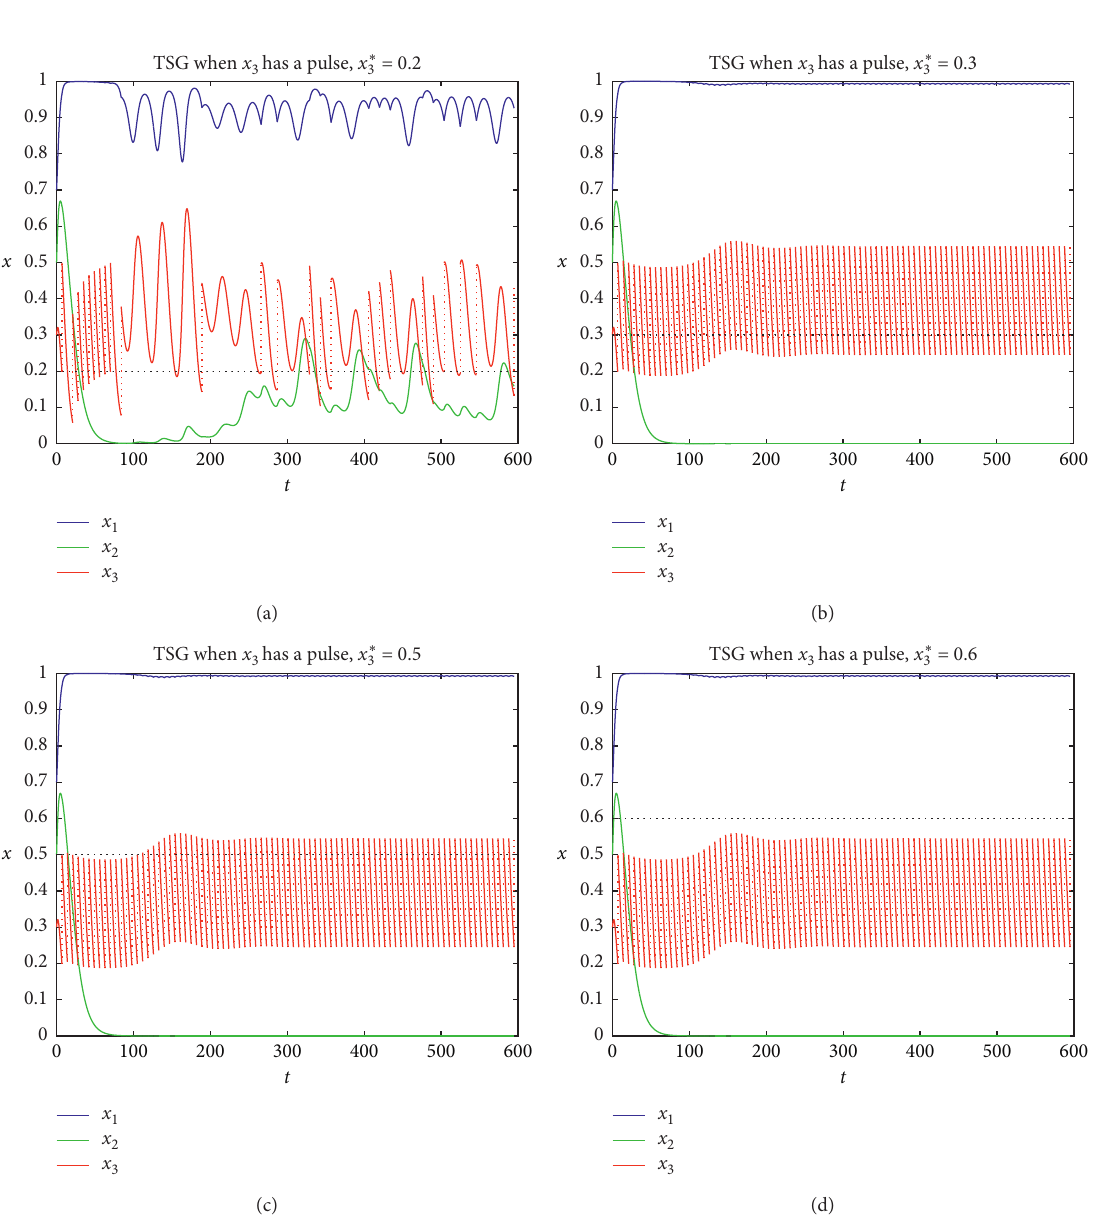
,x , x )| � P ( 0 . 7 , 0 . 5 , 0 . 3 ) . (a) x ∗ t � 0 1 2 3 1